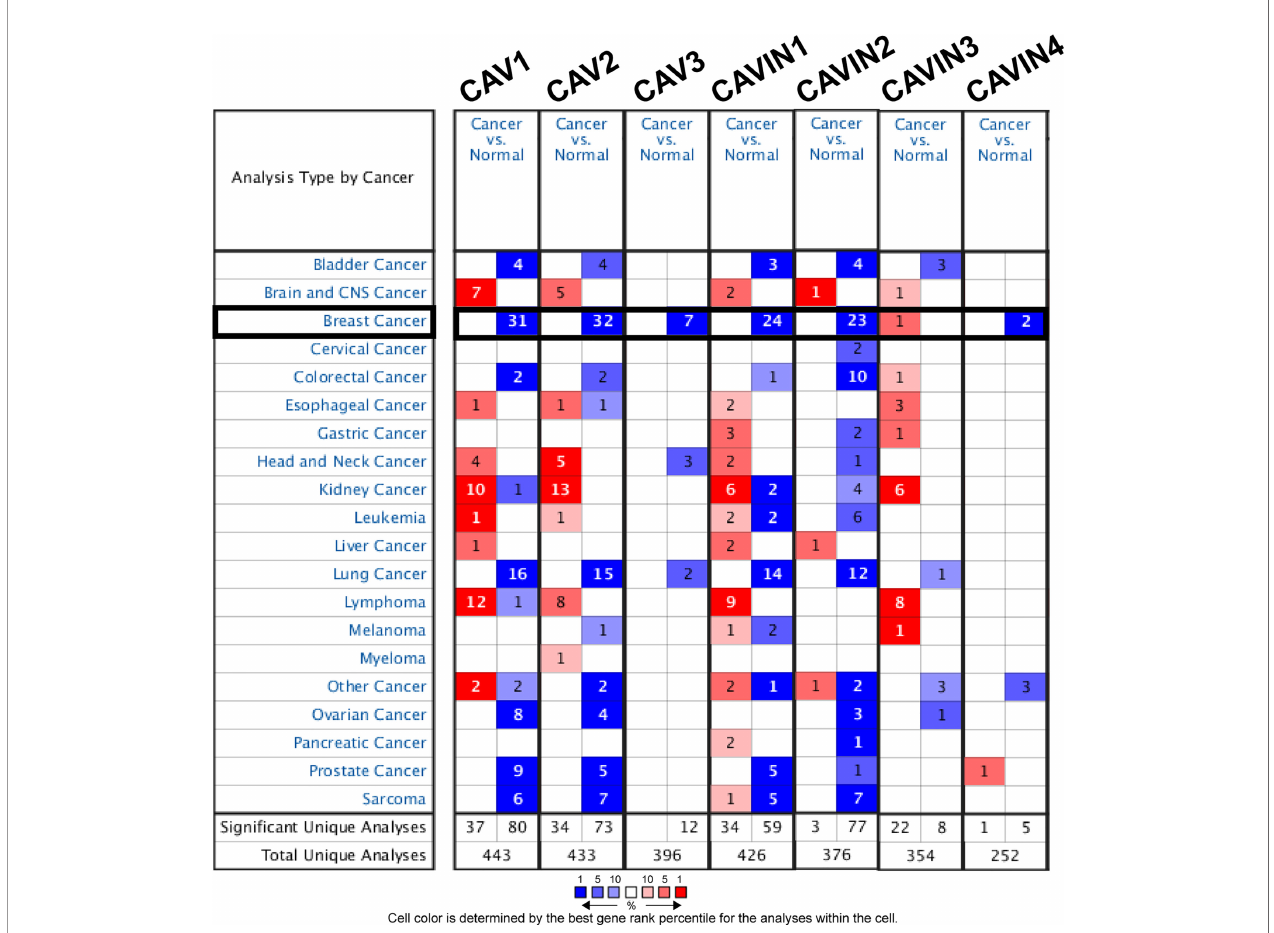
FIGURE 1 | Comparison of transcriptional levels of CAVs and CAVINs in different types of